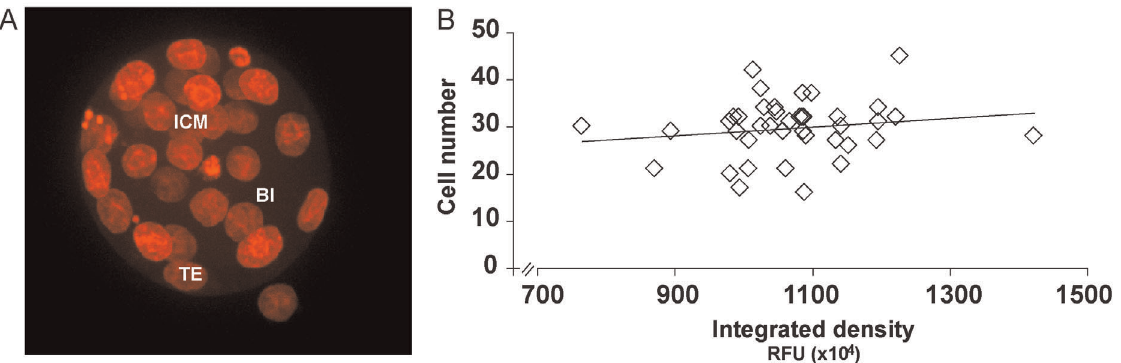
Figure 4. EGFP intensity and embryo cell number. (A) Fertilized (B6C3F1 6 mtGFP-Tg) blastocysts were stained with DRAQ5 to assess total cell number. ICM: inner cell mass; Bl: blastocoel; TE: trophectoderm. (B) Total cell count shows low correlation (r 2 =0.027) with EGFP levels. Each diamond corresponds to one embryo.